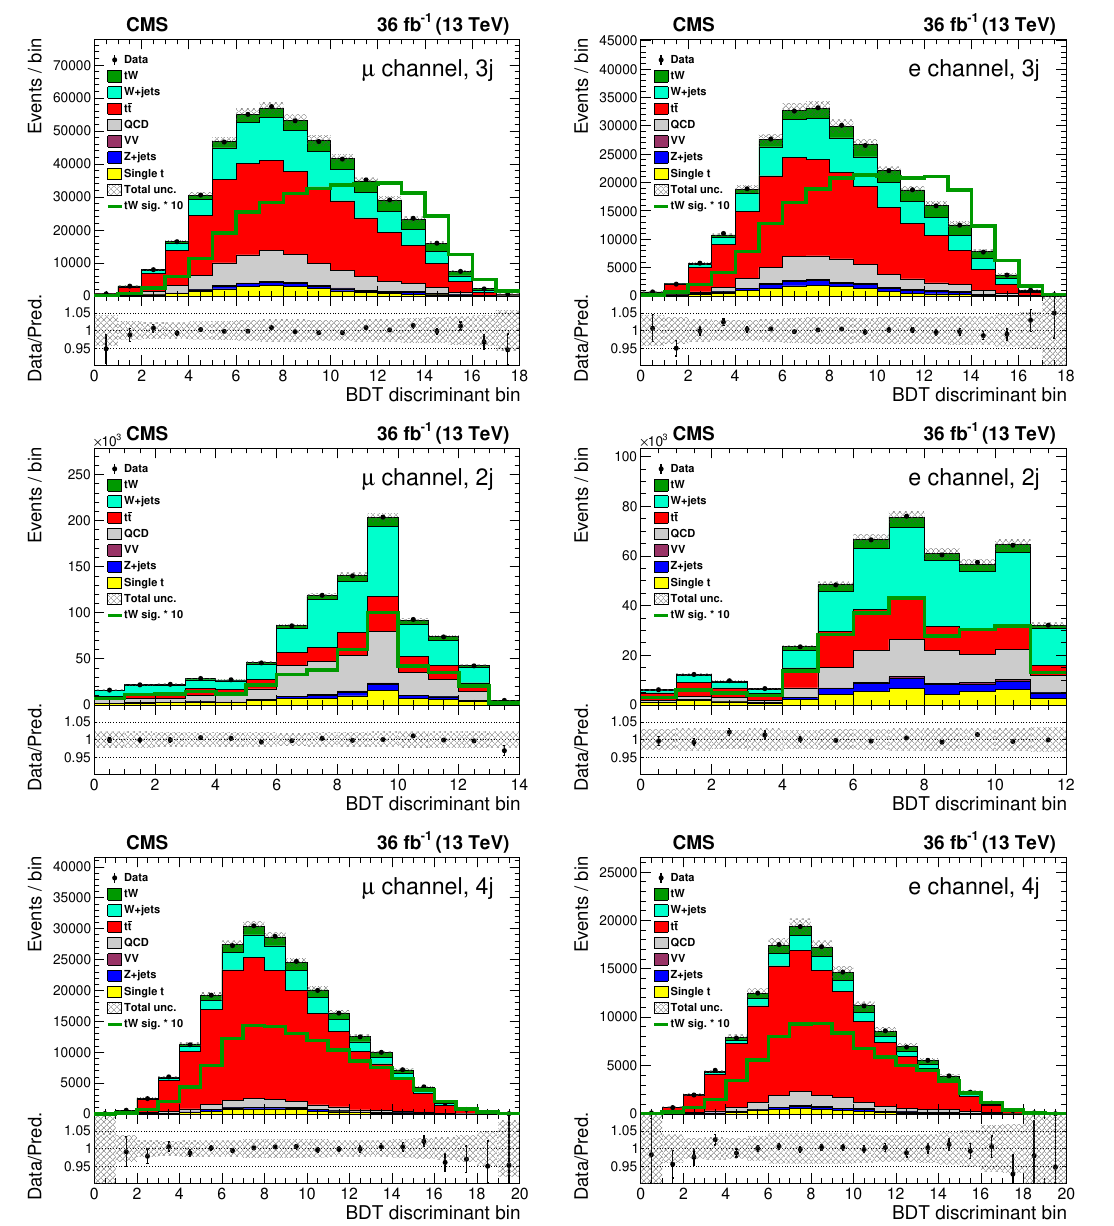
Figure 4 . BDT discriminant in the signal region for the muon (left) and electron (right) channels for the (from upper to lower) 3j, 2j and 4j regions. The upper 3j region is considered the nominal signal region, while the remaining 2j and 4j regions are considered control regions, enhanced in W +jets and QCD multijet, and tt background events, respectively. The shape of the discriminant for the tW signal multiplied by 10 is overlayed. The signal and backgrounds have been scaled with the results of the fit. The lower panel shows the ratio of observed data to the prediction for signal and background. In both panels the hatched regions show the total uncertainty of the